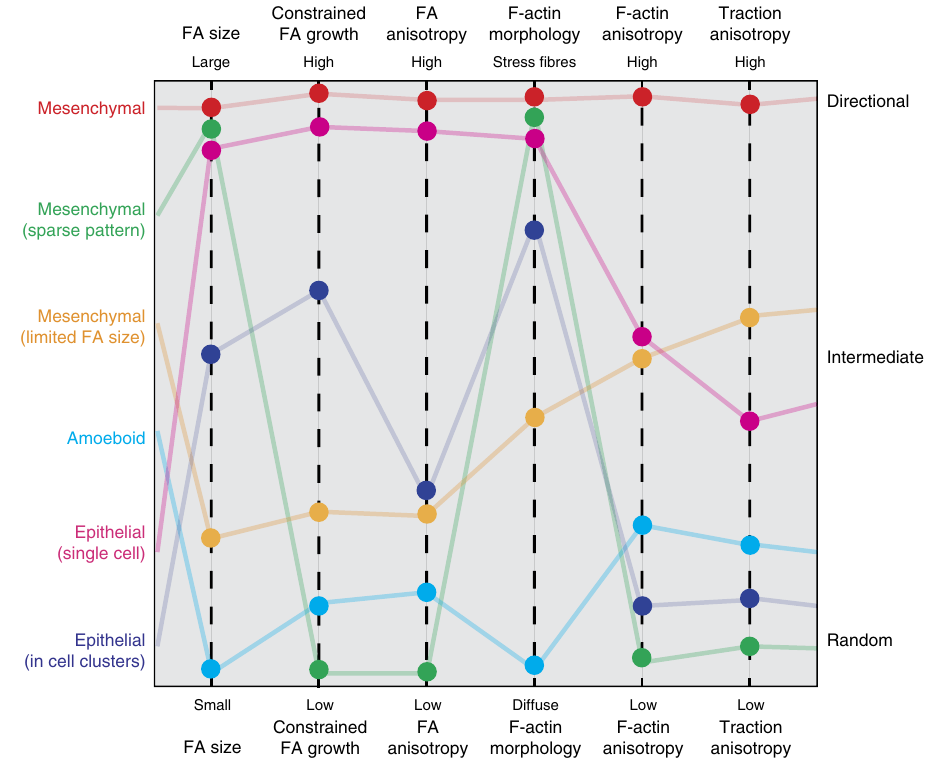
Figure 8 | Contact guidance is driven by constrained focal adhesion growth and modulated by cell phenotype. Schematic diagram showing how disparate cell phenotypes (left most column) differ in the levels of key determinants of contact guidance response (right most column), akin to a tuning model of cell migration 58 . The relative magnitude of each parameter for a given cell type, approximated from our experimental results, is represented by color-coded dots and connected by partially blended lines as a visual aid. Each key parameter may be altered within and across different cell types (as shown in this study) by targeting intracellular and/or extracellular targets. The cumulative findings presented in this figure provide a biophysical roadmap of tunable parameters to interpret, understand and disrupt contact-guided directed migration across diverse carcinoma cell